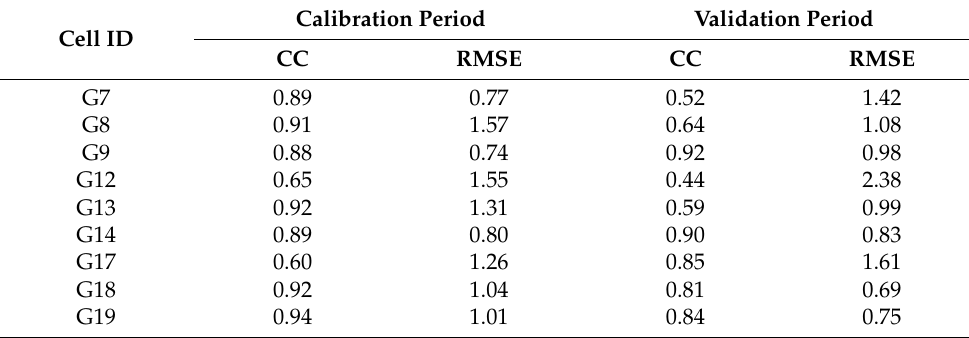
Figure 4. Simulated GWSA from January 2003 to December 2019. Table 2. Coefficient and RMSE for each cell in the calibration and validation periods. Cell